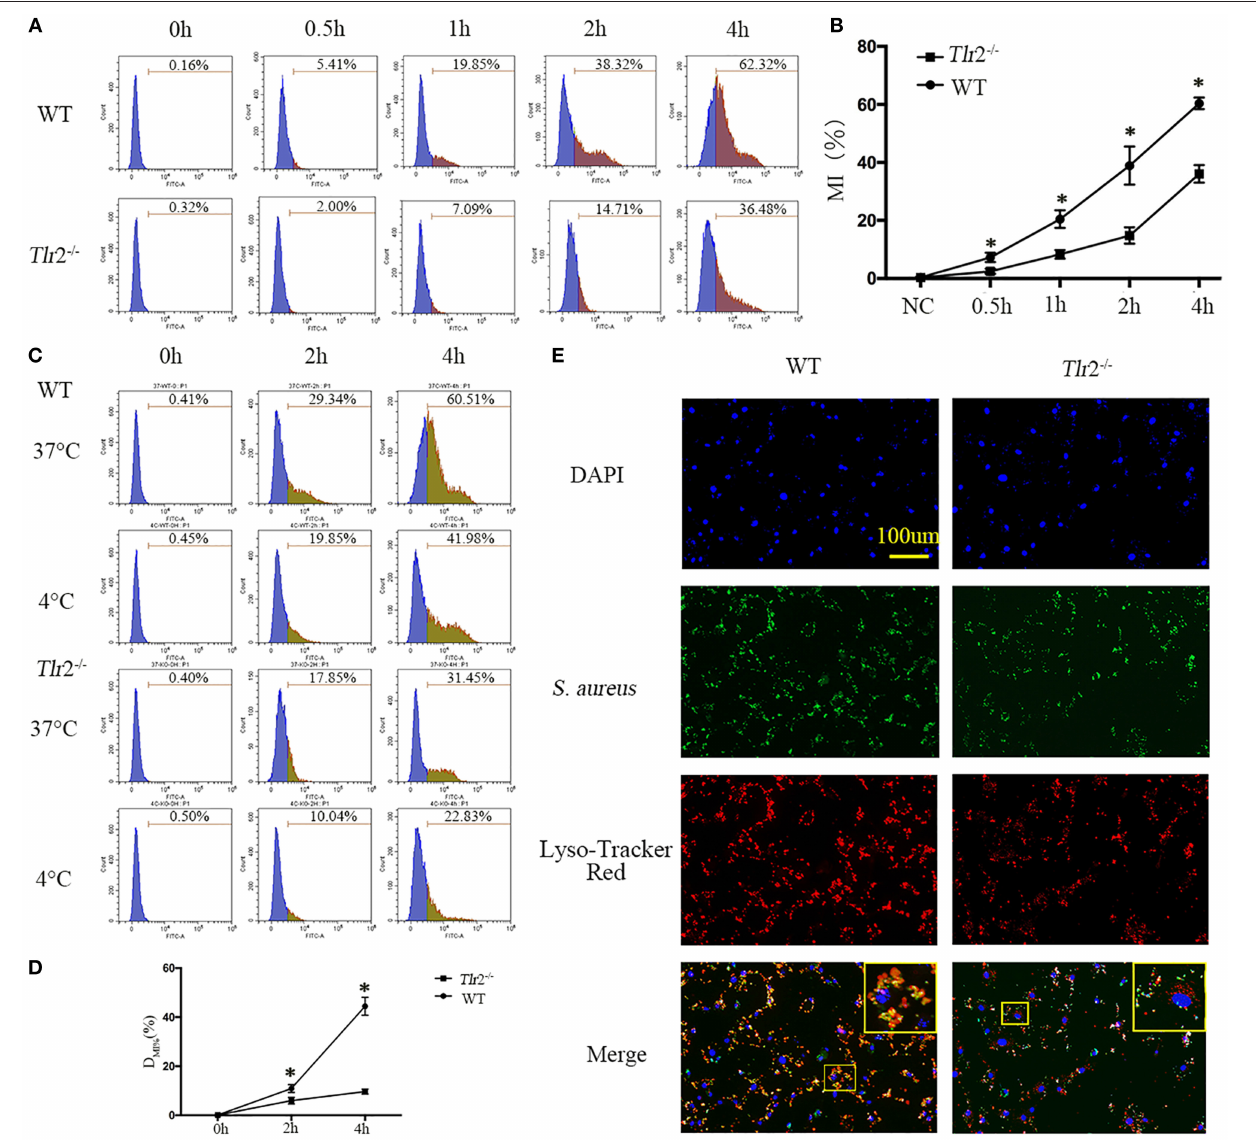
FIGURE 4 | TLR2 regulates the phagocytosis and phagosome maturation of NPCs. (A,B) GFP-labeled S. aureus were incubated with NPCs from wild-type (WT) and Tlr2 − / − mice, after which the interaction was compared by flow cytometry analysis. MI% represents mean intensities percentage. * P < 0.05, the group of WT vs. the group of Tlr2 − / − . (C,D) The mean intensities percentage (MI%) at 4 ◦ C (phagocytosis was inhibited at 4 ◦ C) and 37 ◦ C were analyzed, respectively. A significant difference in D MI % (MI% 37 ◦ C -MI% 4 ◦ C ) was observed in NPCs from WT mice. * P < 0.05, the group of WT vs. the group of Tlr2 − / − . (E) Phagolysosomes formation decreased significantly in Tlr2 − / − NPCs compared with WT NPCs based on Lyso-Tracker Red staining. The scale bar represents 100 µ m. P -values were determined by T -test and one-way ANOVA. All data are presented as the means ± S.D from three independent experiments.